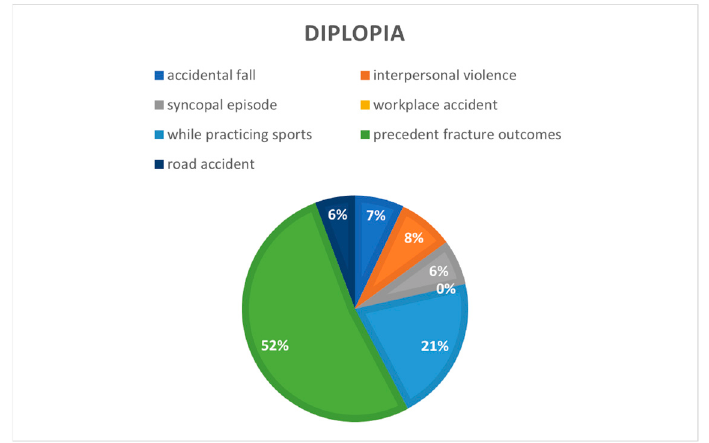
Figure 4. Diplopia correlated to cause of the fractures. Exophthalmos in the considered cohort (Figure 5) were present in 8% of syncopal episodes cases ( n = 2), 3% in interpersonal violence cases ( n = 2) and in 1.3% of road traffic accidents ( n = 2).